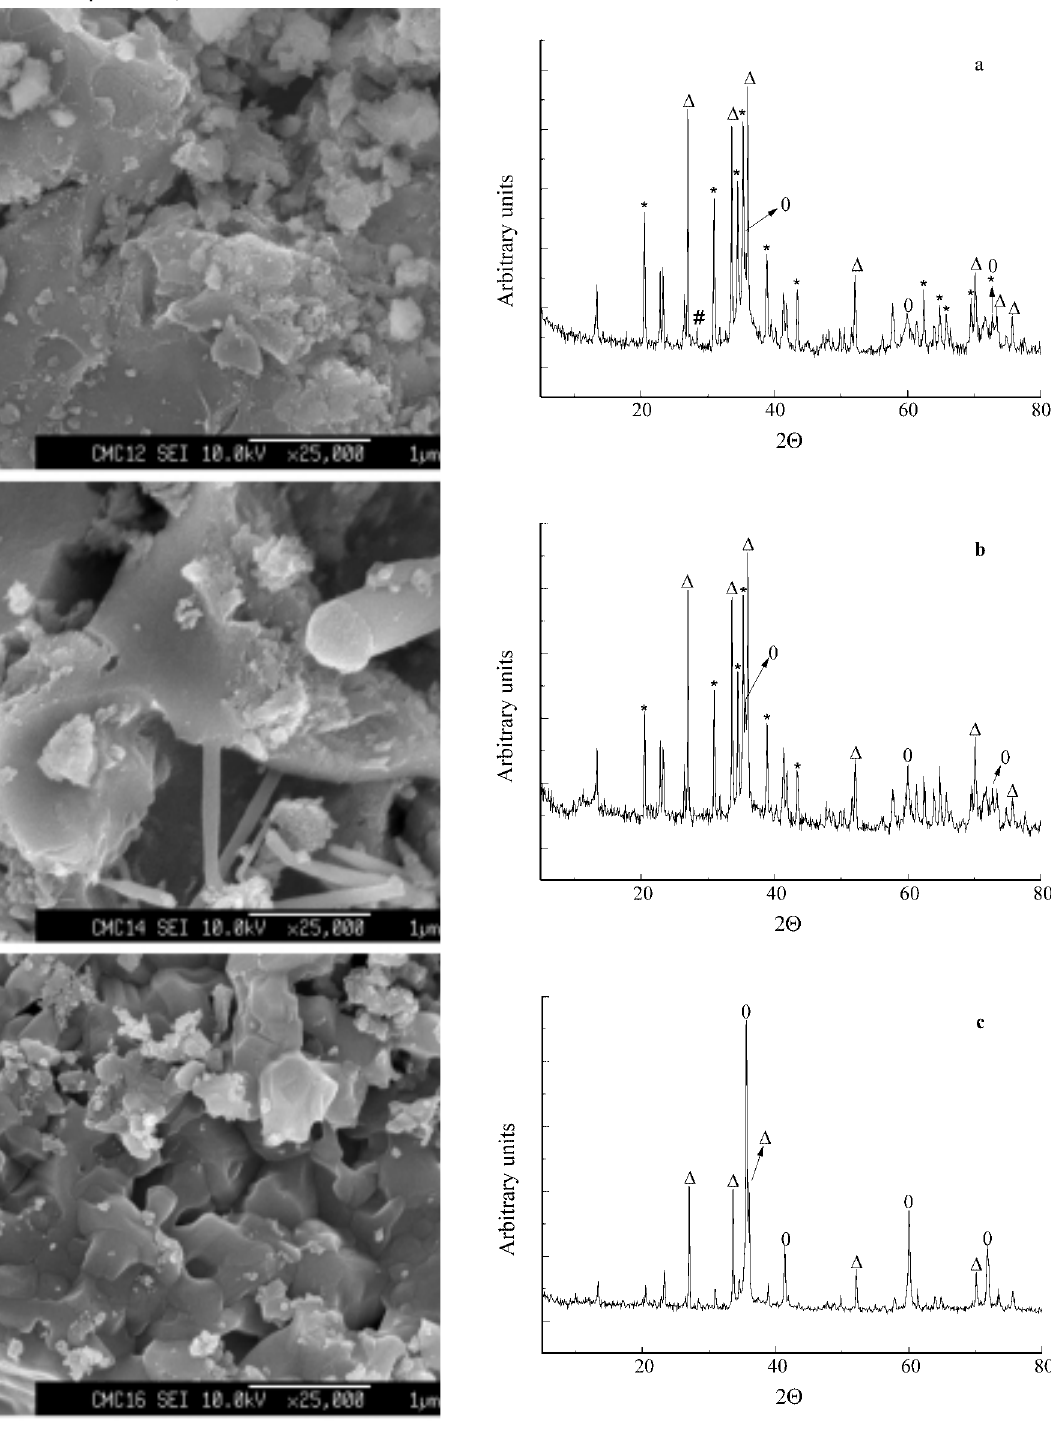
Figure 3. FESEM micrographs and XRD patterns of Si 3 N 4 /SiC heated for 2 h at (a) 1200 °C; (b) 1400 °C; and (c) 1600 °C. XRD peaks legend: *: α -Si 3 N 4 ; ∆ : β -Si 3 N 4 ; #: Si and 0: β -SiC. Not marked peaks: SiO 2